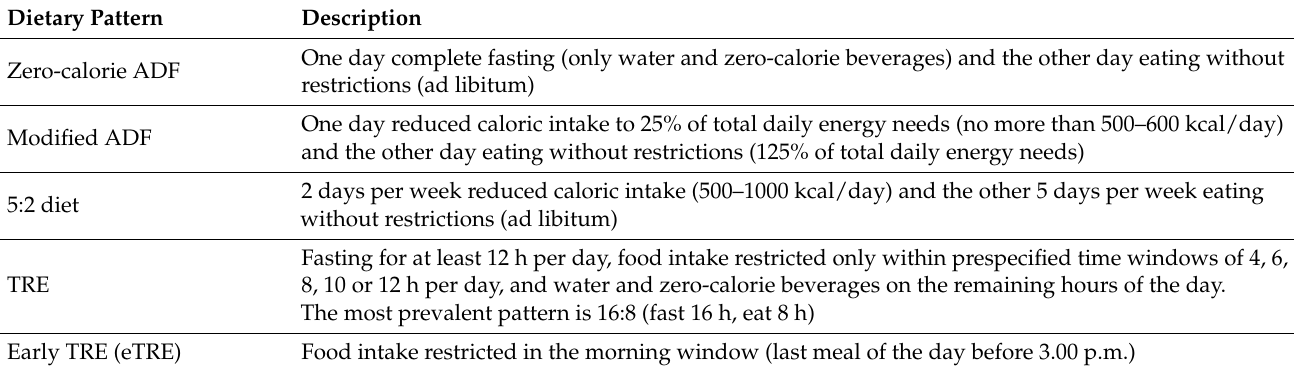
Table 1. The most widely studied dietary regimens of intermittent energy